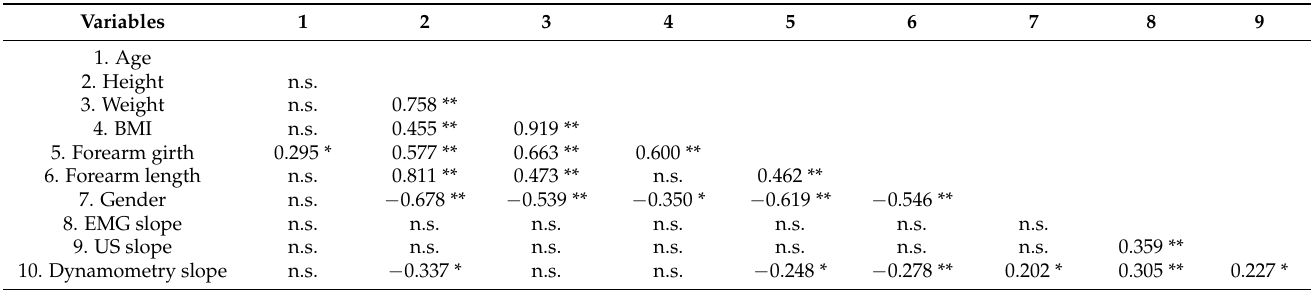
Table 6. Pearson product moment correlation